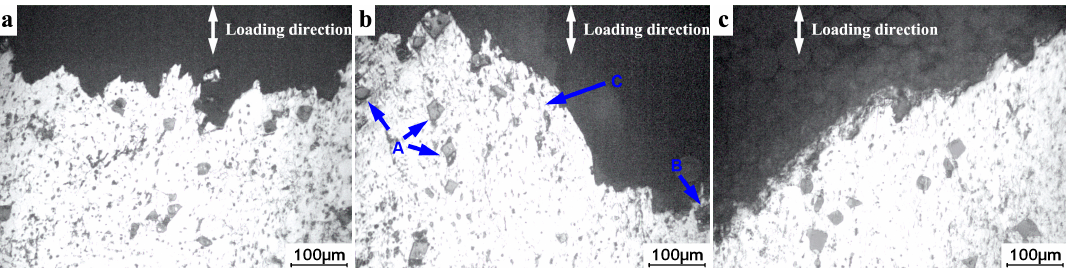
Figure 8. Side view of fracture surface of the thixoforged composite tensile tested at 200 °C under different initial strain rates: ( a ) 0.01 s − 1 ; ( b ) 0.15 s − 1 ; ( c ) 0.2 s − 1 .